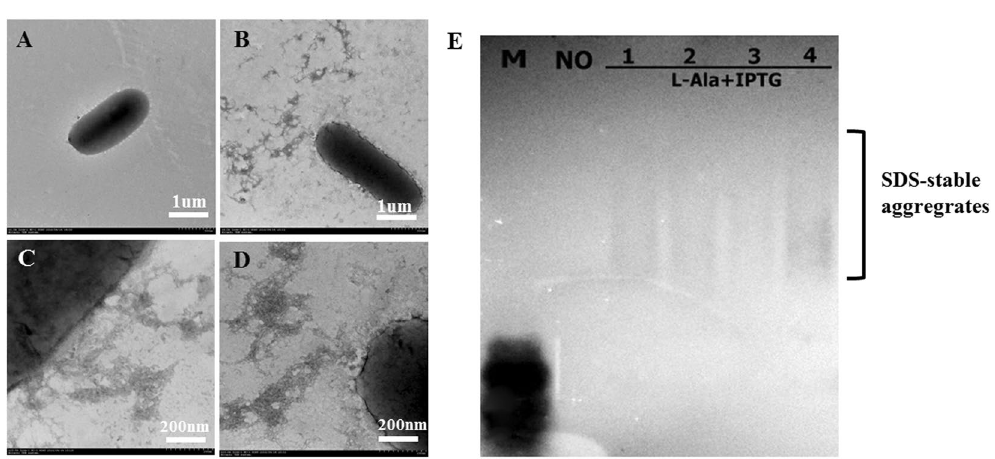
Figure 5. Transmission electron microscopy (TEM) analysis and semi-denaturing detergent agarose gel electrophoresis (SDD-AGE) detection of RFP-M-sup35NM fusion protein. Cells transformed with a plasmid encoding RFP-M-sup35NM fusions were cultured on YESCA uninduced plates ( A ) or induced plates ( B , C , D ) at 25 °C for 3 d. Samples were also analyzed by SDD-AGE, “No” indicates that cells were not induced with IPTG; lanes 1 to 4 represent four induced